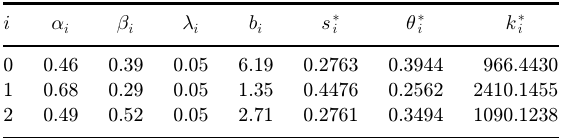
Table 1. Parameter values for a three-sector cluster economic